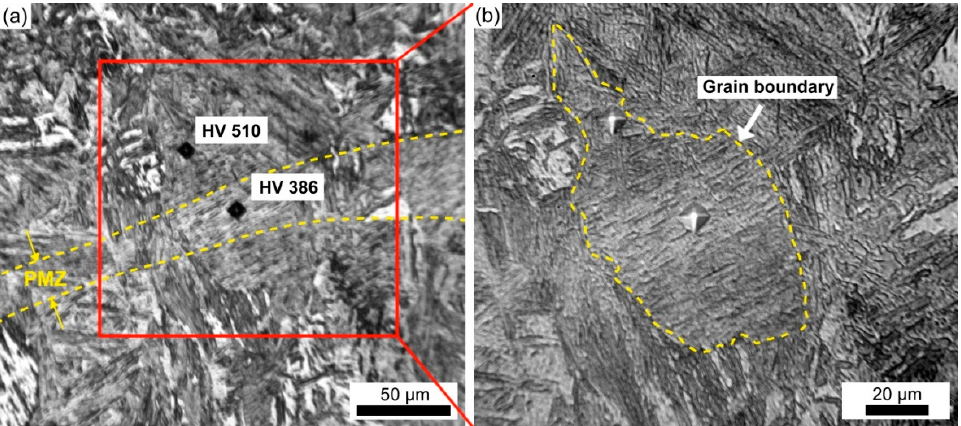
Figure 12. The microhardness in the di ff erent zones in the two-step RSW under OM: ( a ) Overall view; ( b ) enlarged view.